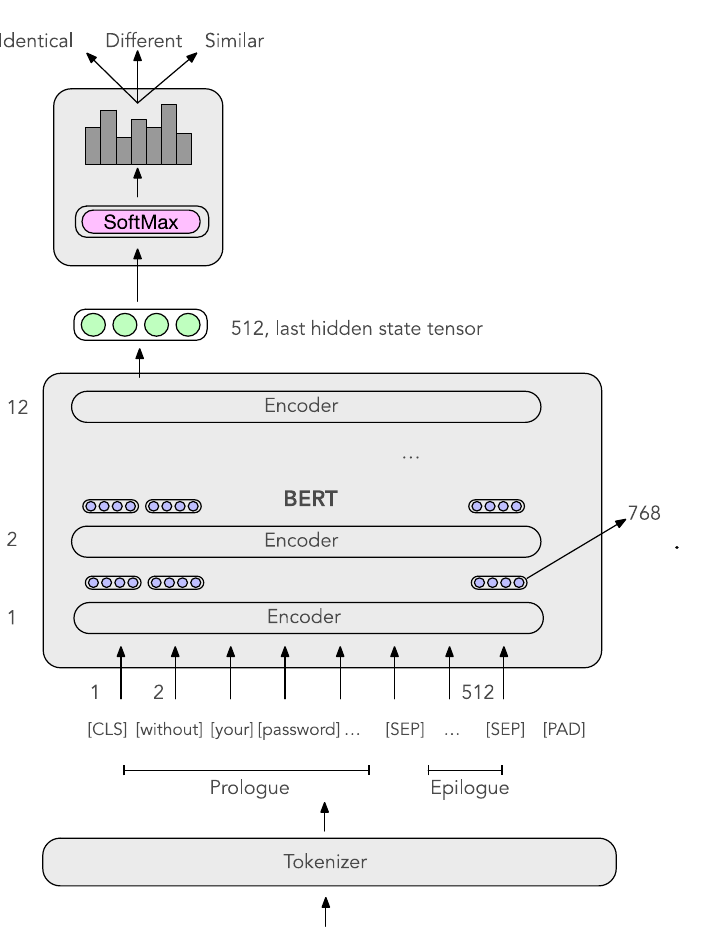
Figure 3. The proposed classification